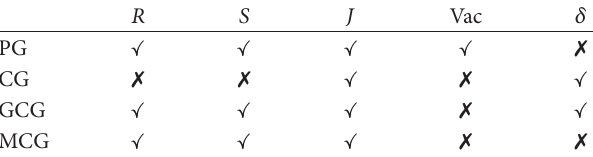
Table 1: Waves involved in the Riemann solutions for different 𝑝(𝜌) . 𝑅 𝑆 𝐽 Vac 𝛿 PG ✓ ✓ ✓ ✓ M CG M M